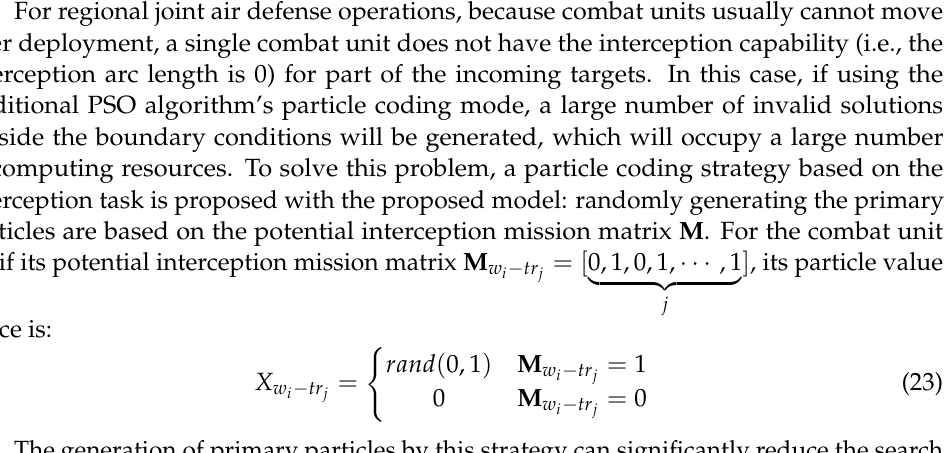
Figure 3. Learning factor value diagram.